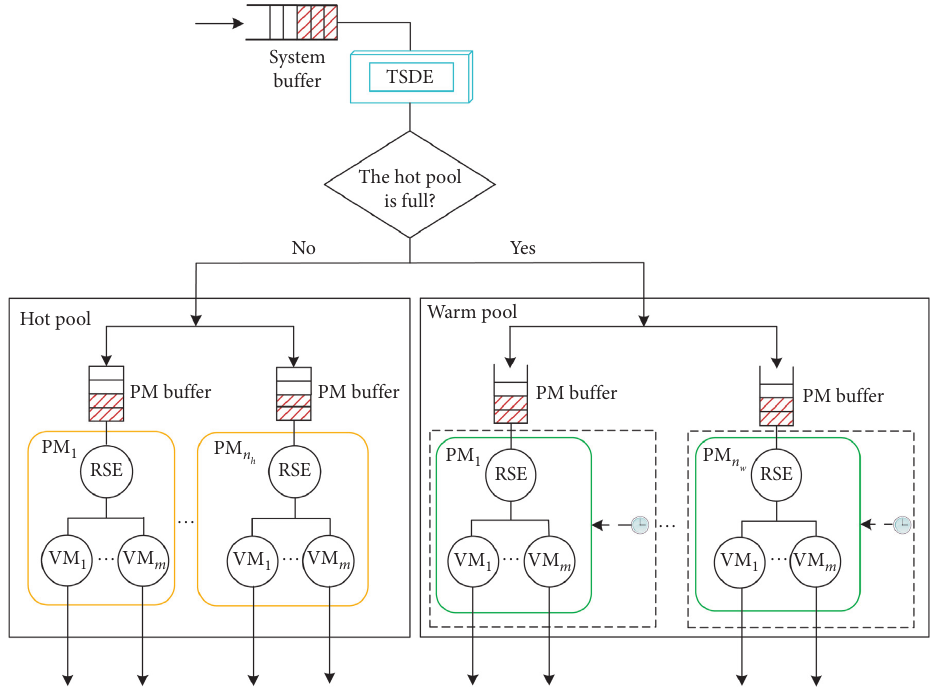
Figure 1: Multitier cloud architecture-based resource management scheme